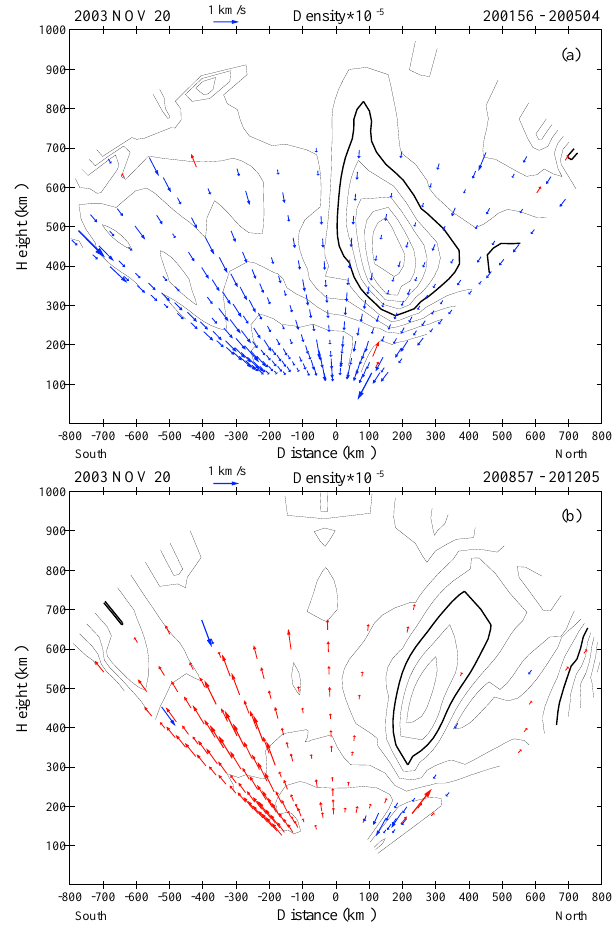
Figure 4. Number density and line-of-sight velocities measured by the Sondrestrom ISR on 20 November 2003, and during the time interval between 20:01:56 and 20:05:04 (west scan, top panel) and 20:08:57 and 20:12:05UT (east scan, bottom panel). Negative (to- ward radar) velocities are indicated in blue, and positive (away from radar) velocities are displayed in red. Density contour lines are used to indicate levels spaced by 10 5 cm − 3 . The thick contour line rep- resents a density value equal to 5 × 10 5 cm − 3 . The radar antenna conducted composite scans in which azimuth and elevation were varied to keep the scan plane almost parallel to the magnetic merid-